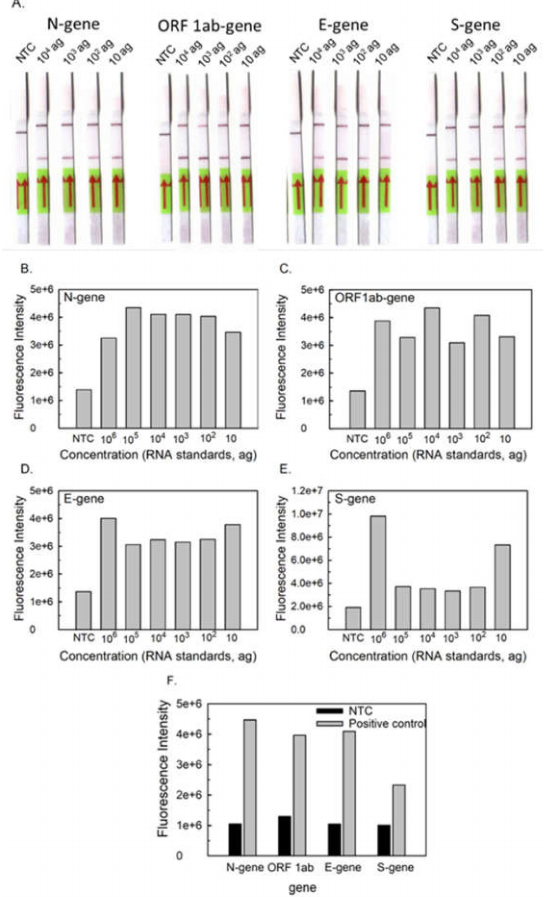
Figure 2. Sensitivity of RT-LAMP-based LFD of SARS-CoV-2 using in vitro transcribed viral mRNA. ( A ) LFD of RT-LAMP amplified in vitro transcribed standard RNA and no template control (NTC); ( B – E ) Fluorescence detection of 10-fold diluted RT-LAMP amplified products of in vitro transcribed mRNA standards using SYBR Green I dye. ( F ) Fluorescence detection of RT-LAMP amplified products using SYBR Green I dye for no template control (NTC) and positive control (PC; 1.0 ng µ L − 1